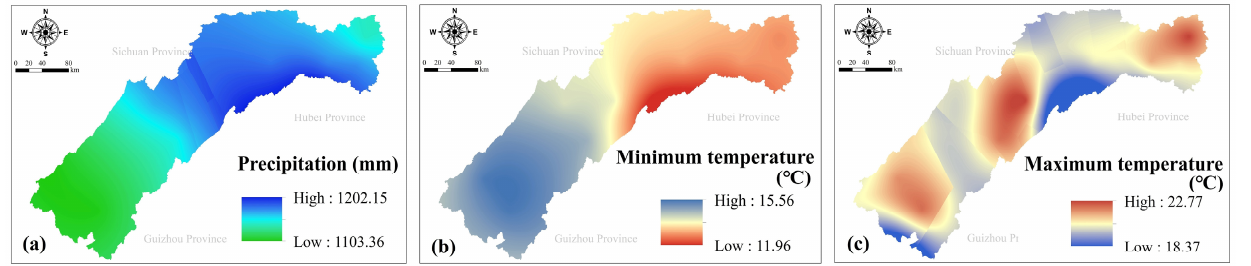
Figure 5. Spatial distribution of precipitation ( a ), minimum ( b ), and maximum temperature ( c ) in the TGRA.